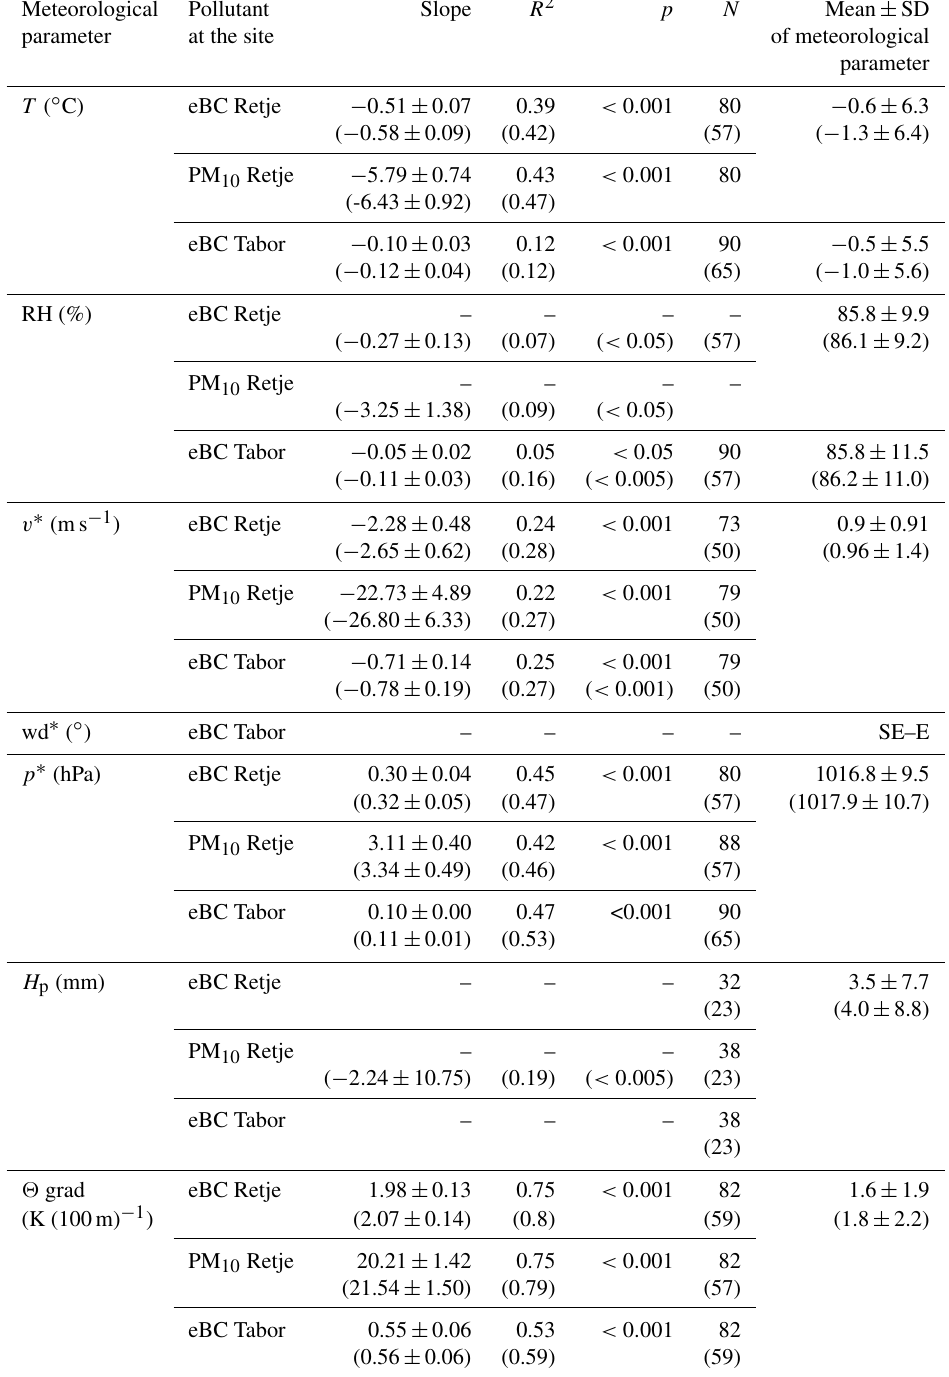
Table 7. Regression results for the relation between meteorological conditions, eBC and PM 10 mass concentrations (µgm − 3 ) (24h averages) in winter 2017–2018, and selected days with temperature inversion and unstable atmosphere (in brackets) at both air quality stations – the Retje rural village station (eBC and PM 10 ) and the Tabor rural background station (eBC). In the last column the means of meteorological parameters with SD are